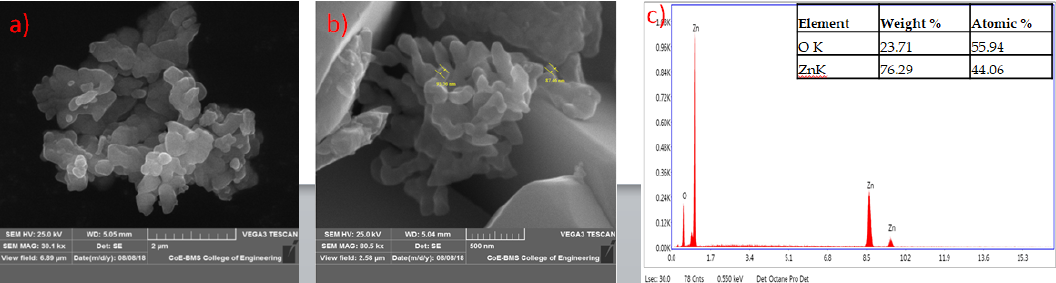
Figure 7. SEM image of zinc oxide nanoparticles synthesized from Trichoderma reesei (PGT13) at lower ( a ) and higher ( b ) magnification; ( c ) represents energy-dispersive X-ray spectroscopy (EDAX) analysis.